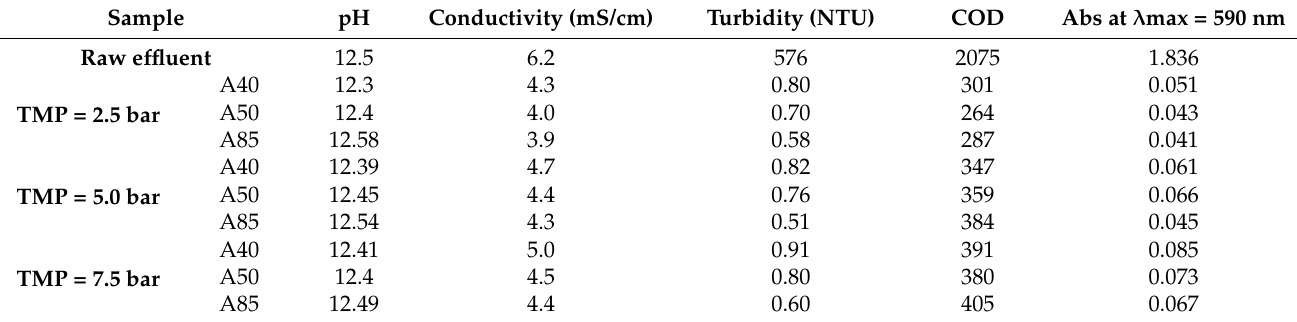
Table 5. Characteristics of the effluent before and after filtration using the different membranes.